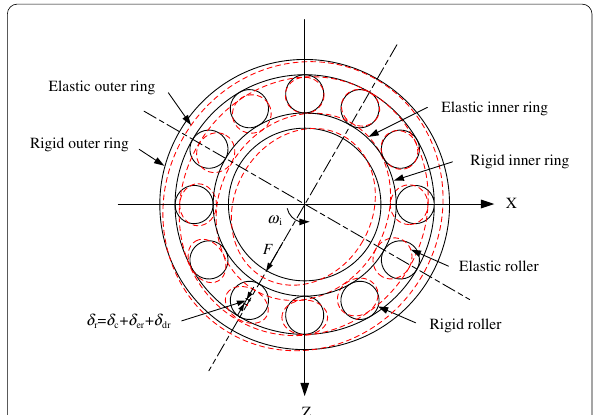
Figure 4 Comparison between the rigid and elastic rolling